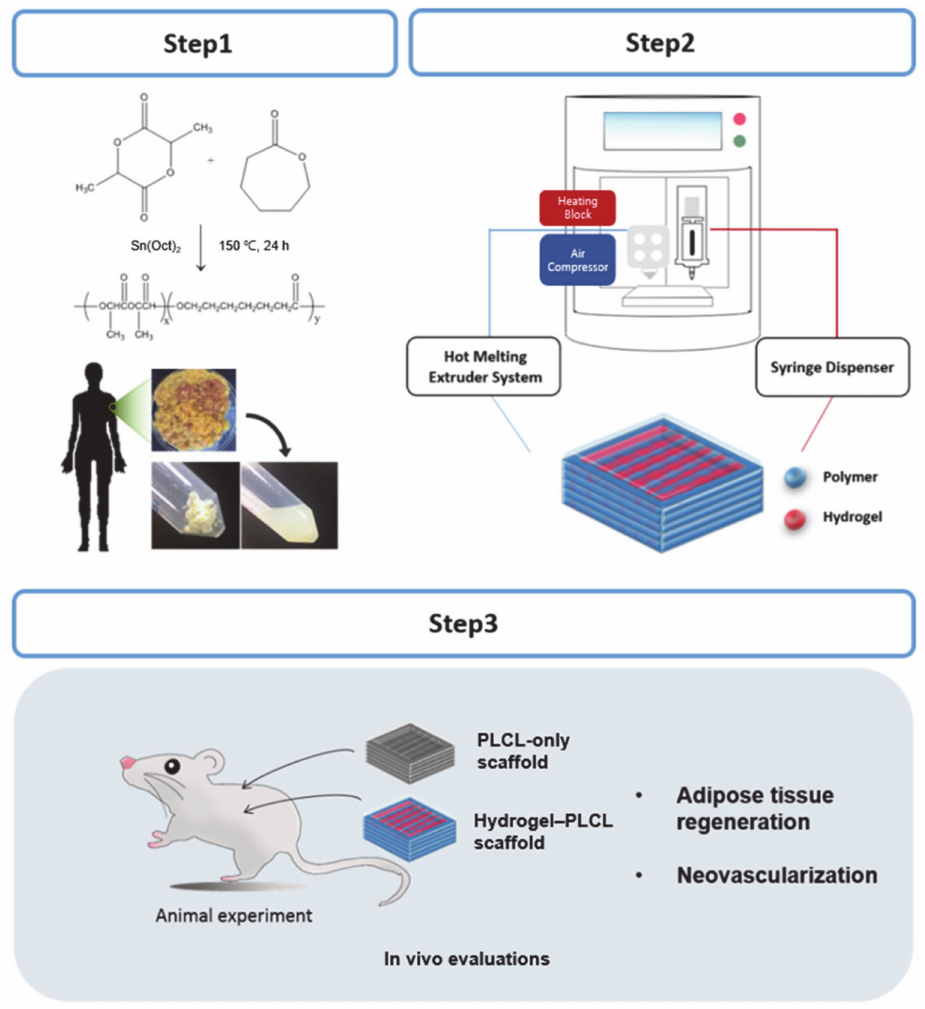
Figure 1. Schematic explanation of the research strategy. An elastic copolymer, PLCL, was syn- thesized by ring-opening polymerization, and the hydrogel was made with decellularized adipose tissue extracellular matrix (ECM) and collagen. Three-dimensional (3D) printing was performed with the PLCL and hydrogel inks with a hot melting extruder and syringe, respectively. The 3D-printed scaffolds were subcutaneously implanted in rats for the in vivo